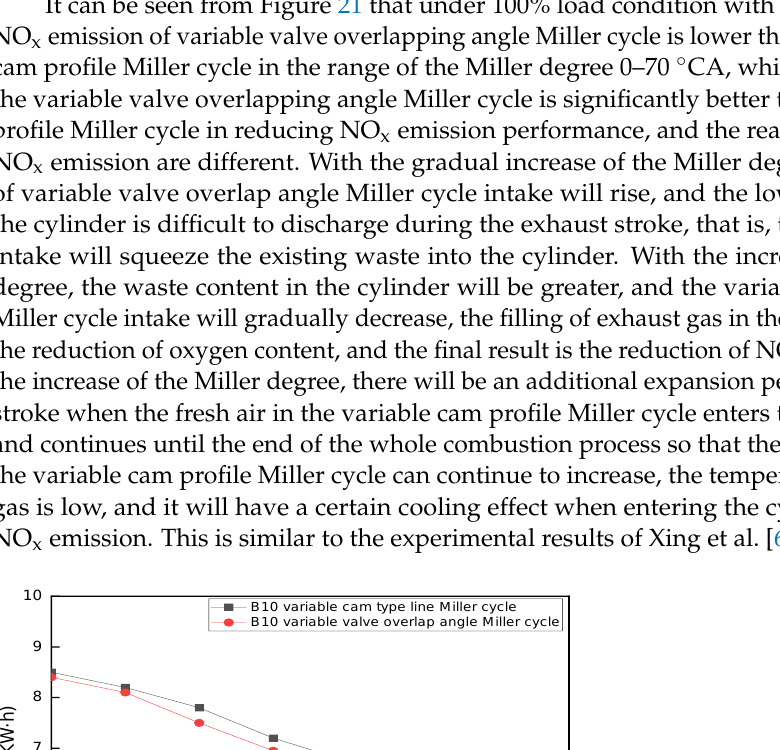
Figure. 21 comparison of NOx emission of two Miller cycles It can be seen from Figure 21 that under 100% load condition with B10 biodiesel, the NOx emission of variable valve overlapping angle Miller cycle is lower than that of vari- able cam profile Miller cycle in the range of Miller degree 0-70 ° Ca, which can reflect that the variable valve overlapping angle Miller cycle is significantly better than variable cam profile Miller cycle in reducing NOx emission performance, and the reasons for reducing NOx emission are different, With the gradual increase of Miller degree, the pressure of variable valve overlap angle Miller cycle intake will rise, and the low-pressure gas in the cylinder is difficult to be discharged during the exhaust stroke, that is, the high-pressure intake will squeeze the existing waste into the cylinder. With the increase of Miller degree,